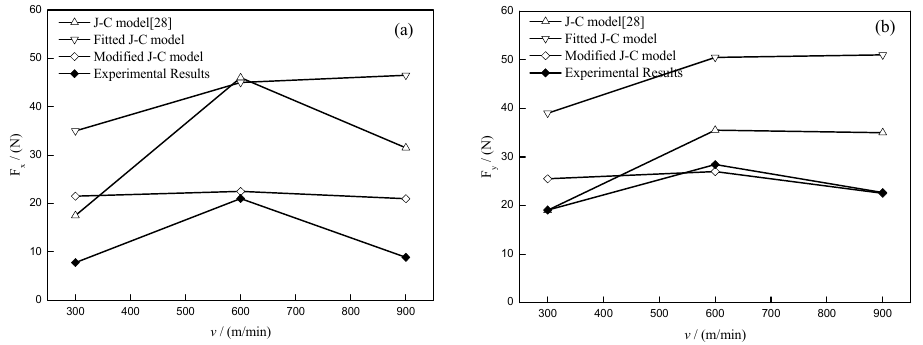
Figure 10. Diagram of cutting force changing with speed: (( a )Feed direction force F x , ( b ) tangential force F y ).